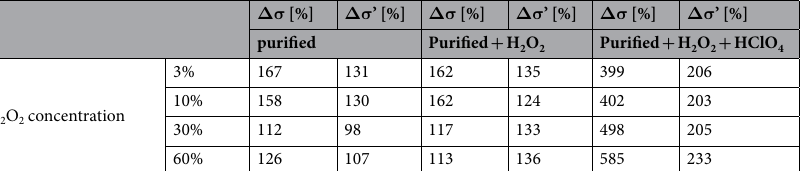
Table 1. Percentage conductivity change after purification (annealing, acetone and HCl soaking), purification followed varying concentration H 2 O 2 treatment, and finally after purification followed by H 2 O 2 and HClO 4 treatment. Percentage changes relate to the as-made